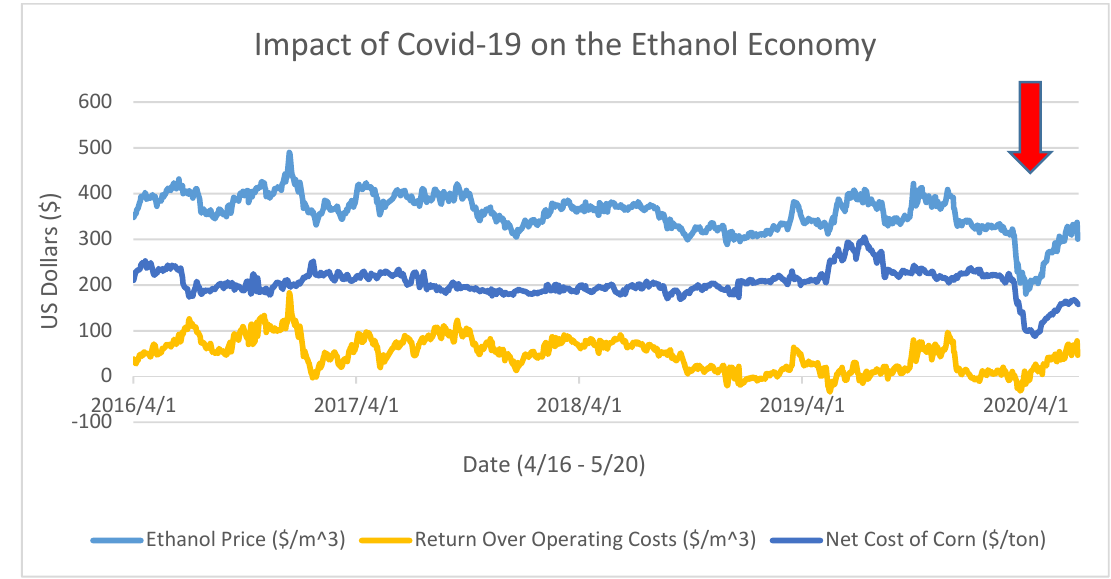
Figure 5. Prices of ethanol (2015–2020) [12]. A red arrow indicates an example of the recent price drop caused by the SARS-Cov-2 outbreak.